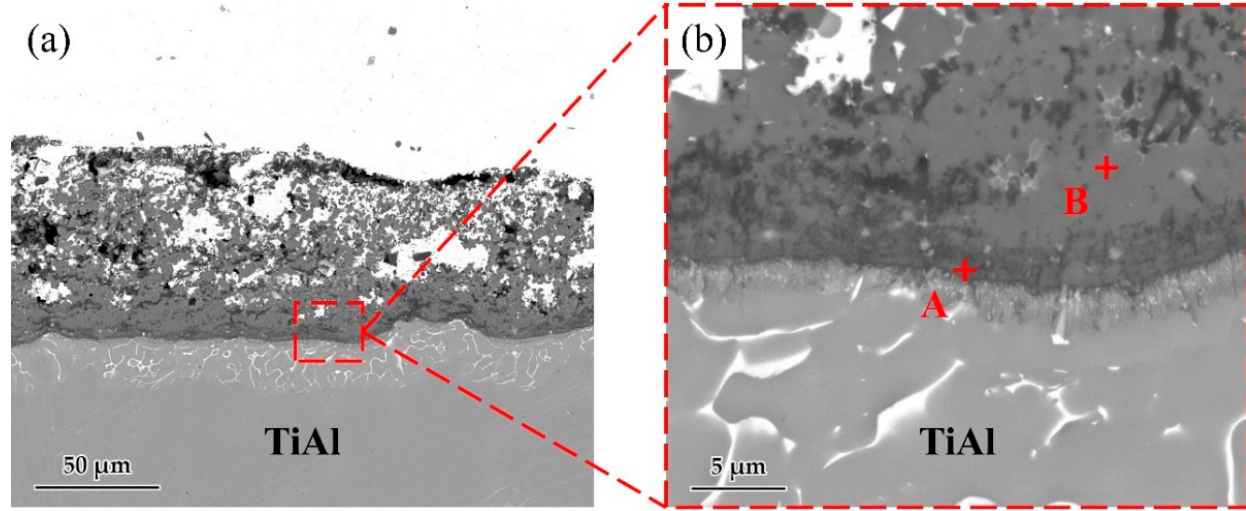
Figure 5. ( a ) Microstructure of Ag-2CuO filler/TiAl cross section. ( b ) High magnification image of marked zone in Figure 3a. Table 3. EDS result of each spot in Figure 5 (at. %).